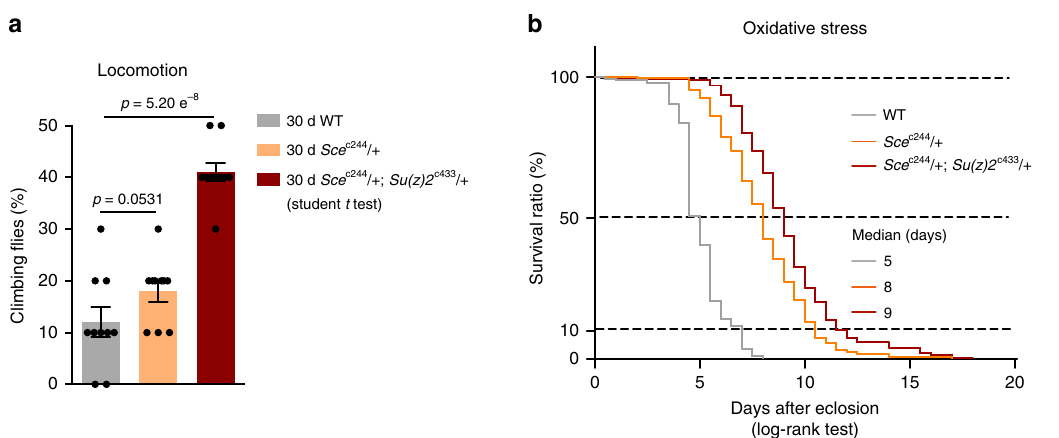
Fig. 5 Reducing ubH2A couples with an effect to promote adult fi tness. Analysis of adult phenotypes reveals that Sce c244 / + single mutants and Sce c244 / + ; Su(z)2 c433 / + double mutants have better climbing ( a ) and enhanced resistance to oxidation ( b ) than age-matched WT. (for climbing assay: mean±s.e.m. of 10 biological repeats with 10 male fl ies for each repeats; student t test; for oxidation tests: 25°C, n >100 male fl ies per genotype for curve, log-rank